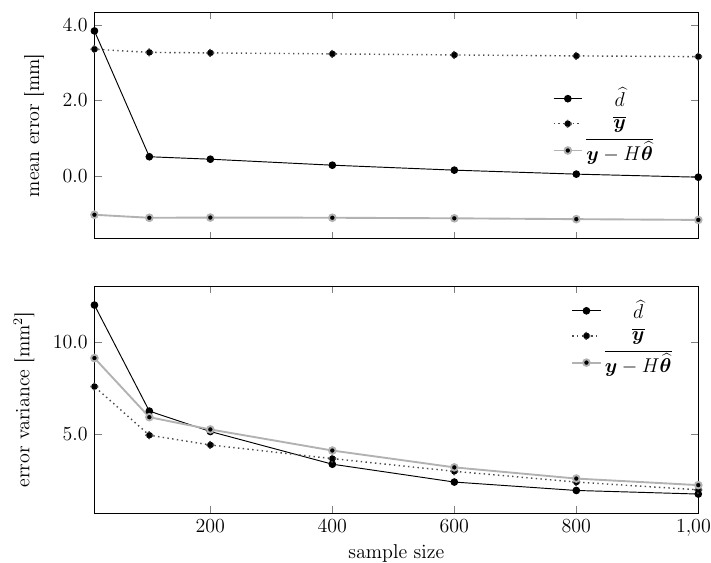
Figure 18. Dependency of the statistical moments of the various estimators on the test sample size. The upper plot shows the mean error, while the lower plot shows the variance of the error. In these experiments, the temperature of the device ranged between 24.8 °C and 28.8 °C.